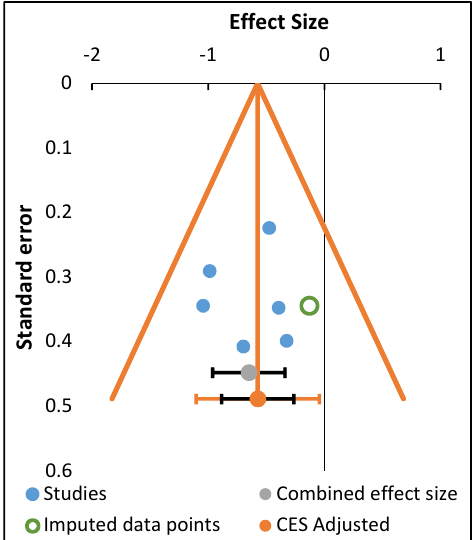
Figure 3. Trim and Fill funnel plot (Mental Health).